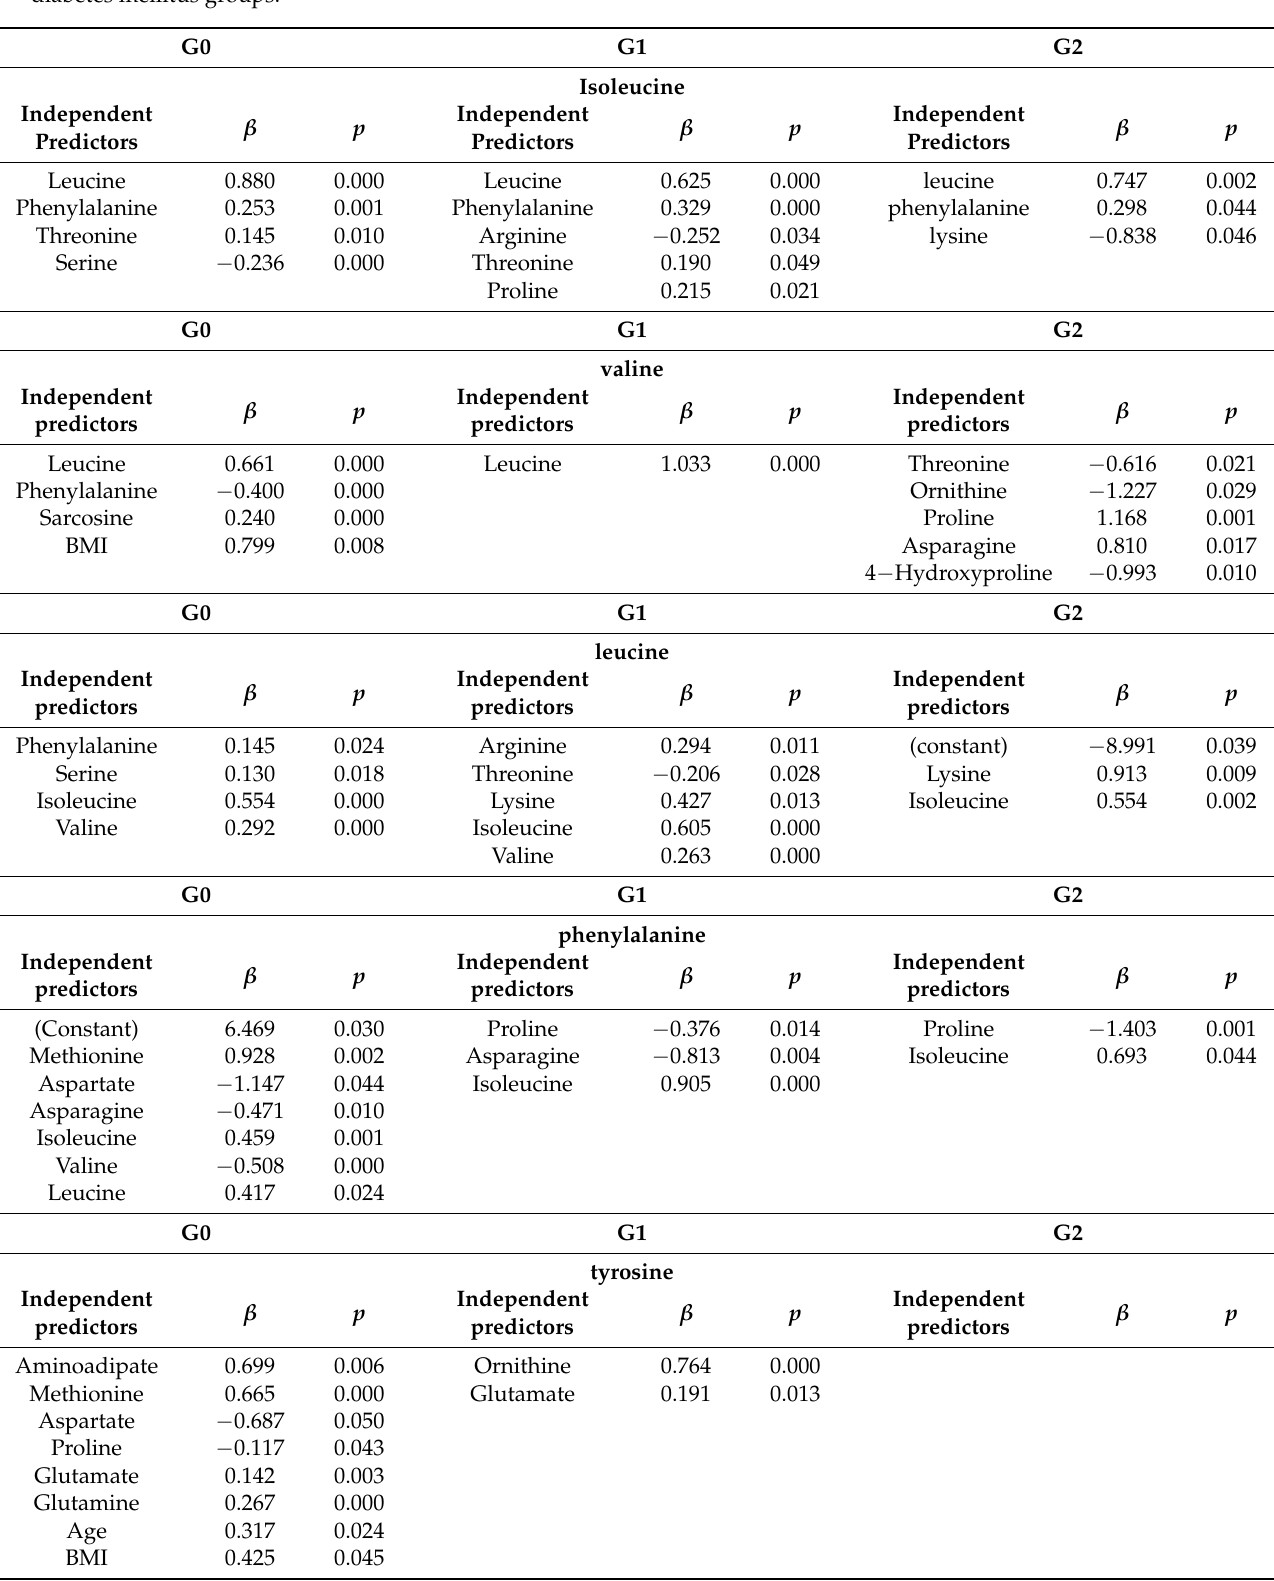
Table 4. Regression analysis showing the AAs that are independent predictors (including age and BMI as independent variables); B coefficient ( β ) and significance ( p ); healthy controls (G0), single-treated (G1) and multi-treated (G2) type 2 diabetes mellitus